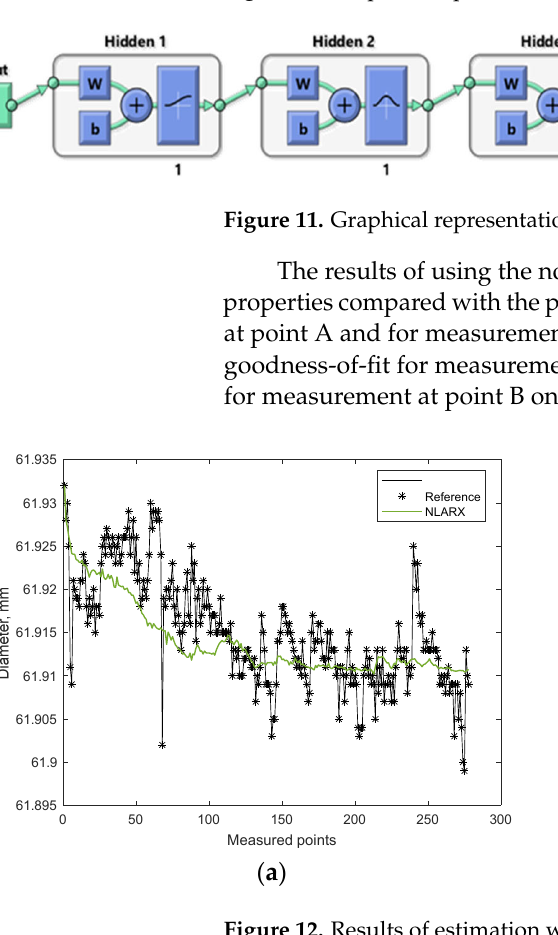
Figure 10. Graphical representation of the NLARX model.